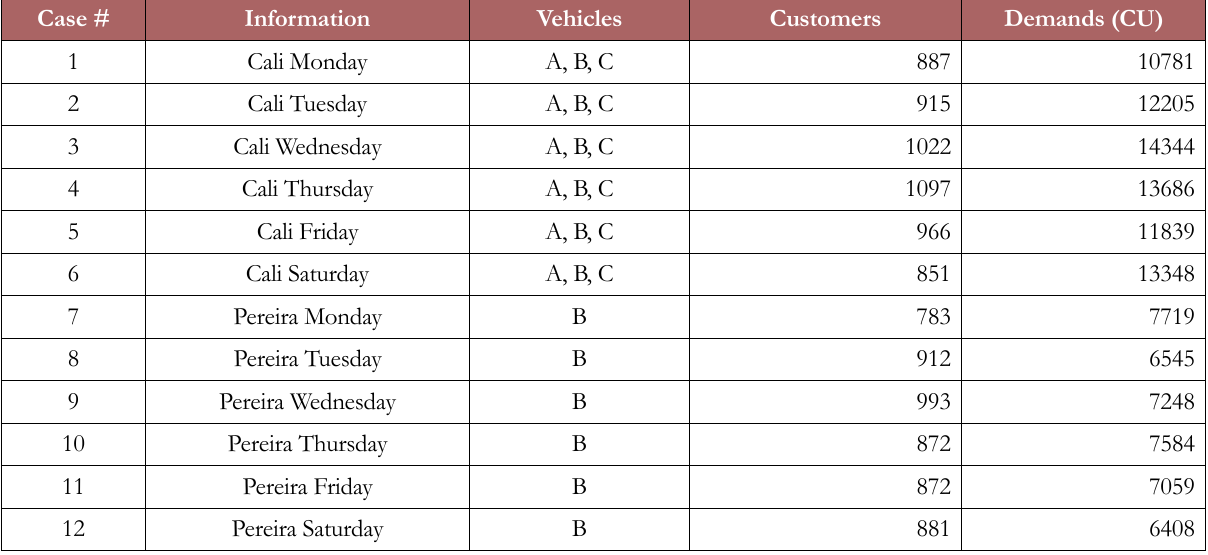
Table 1. Characteristics of the case of